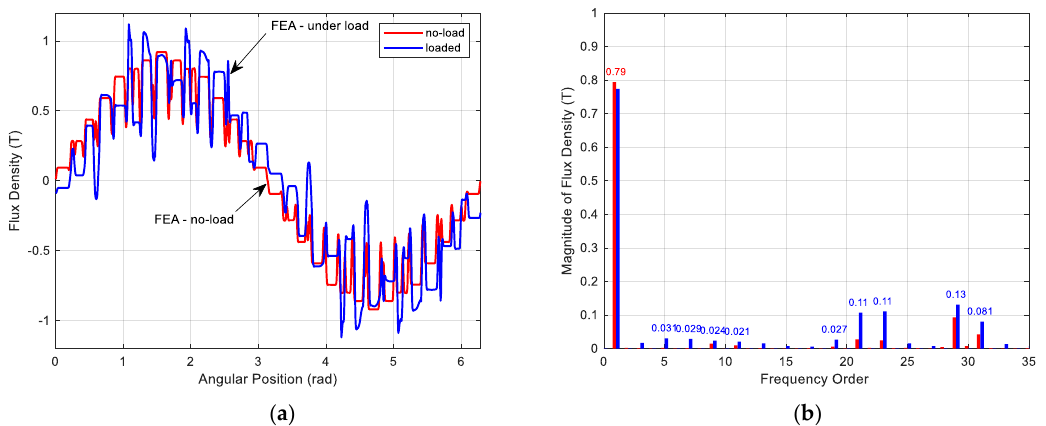
Figure 6. ( a ) Comparison between no-load and loaded operational state; field distribution ( b ) from FEA, frequency spectrum (right).